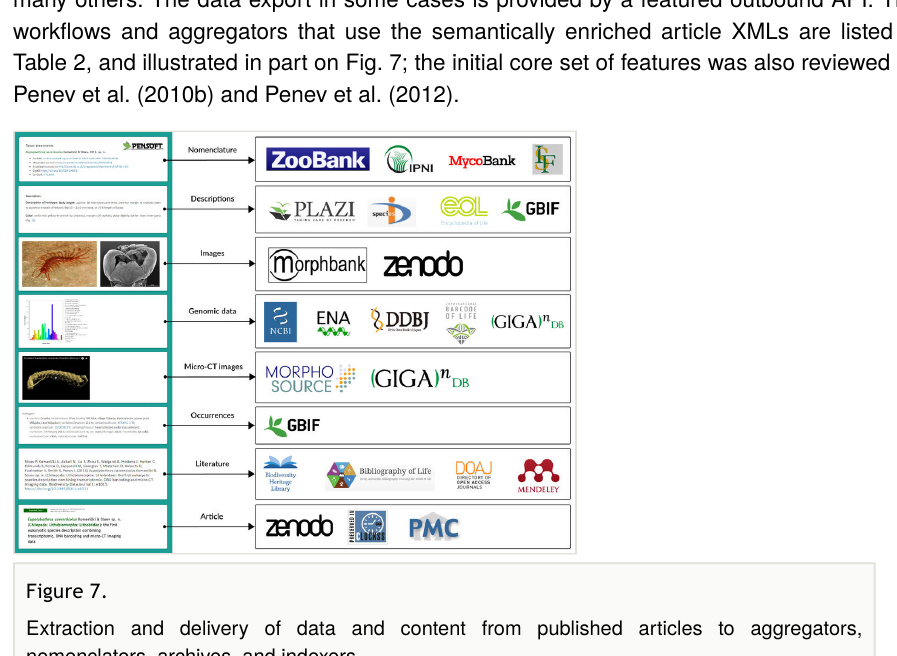
Extraction and delivery of data and content from published articles to aggregators, nomenclators, archives, and